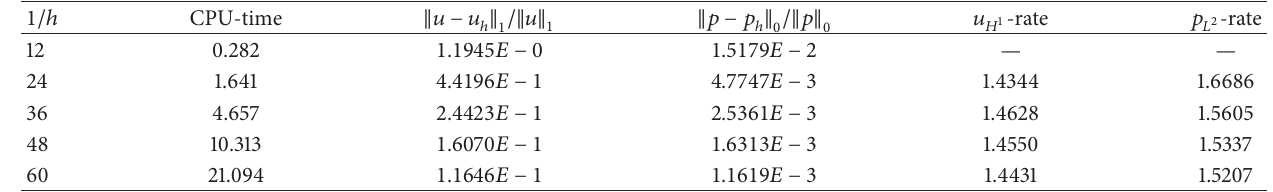
Table 2: Results got from the regular method with ] = 1.0𝑒 − 4 , 𝛼 = 1.0𝑒 − 4 , and 𝑟 = 3